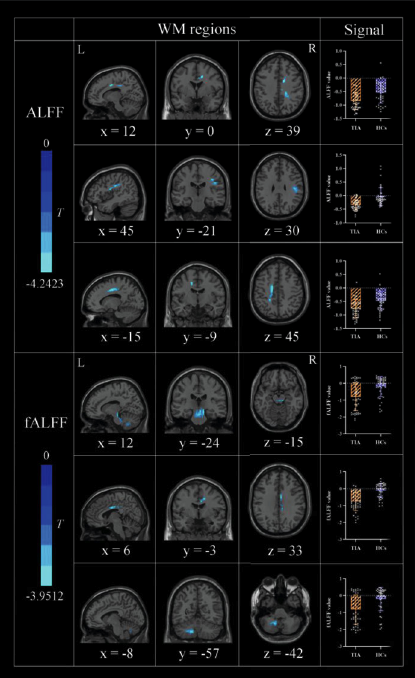
Figure 2: Regions of WM showing group di ff erences in ALFF and fALFF together with signal values extracted from these regions.